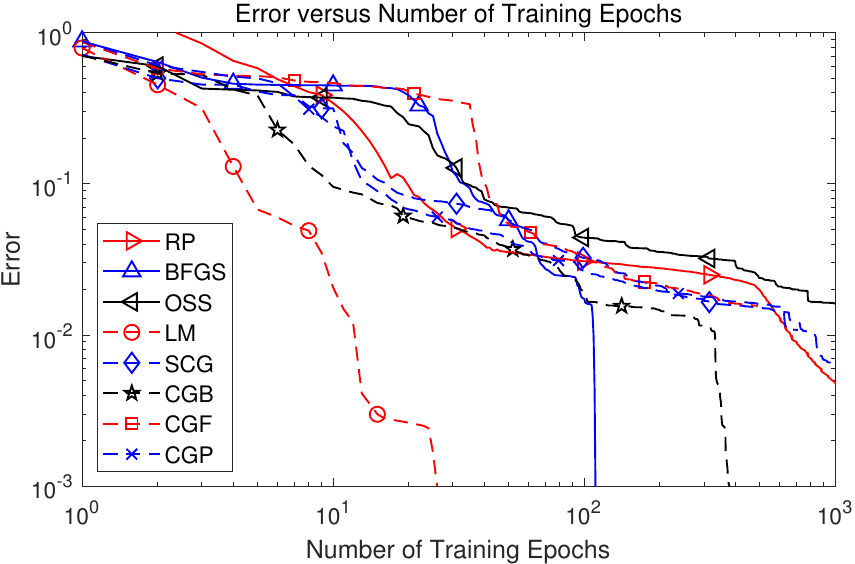
Figure 4. A 4-4-3 MLP trained with eight methods: the evolution curves of the training error for a random